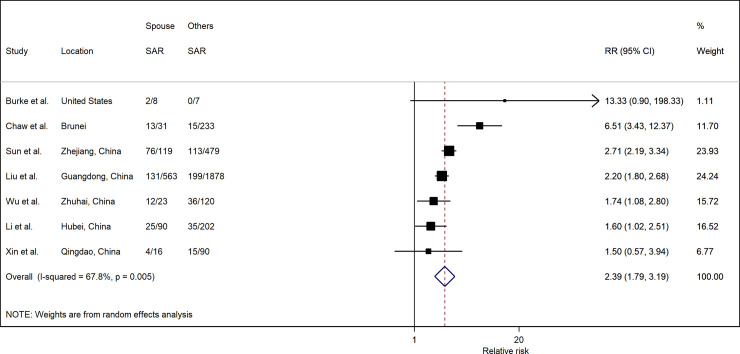
Forest plot of household transmission risk by relationship to index case.RR is the estimated risk ratio, with 95% confidence intervals (CI). I-squared is the percentage of between-study heterogeneity that is attributable to variability in the true effect, rather than sampling variation.